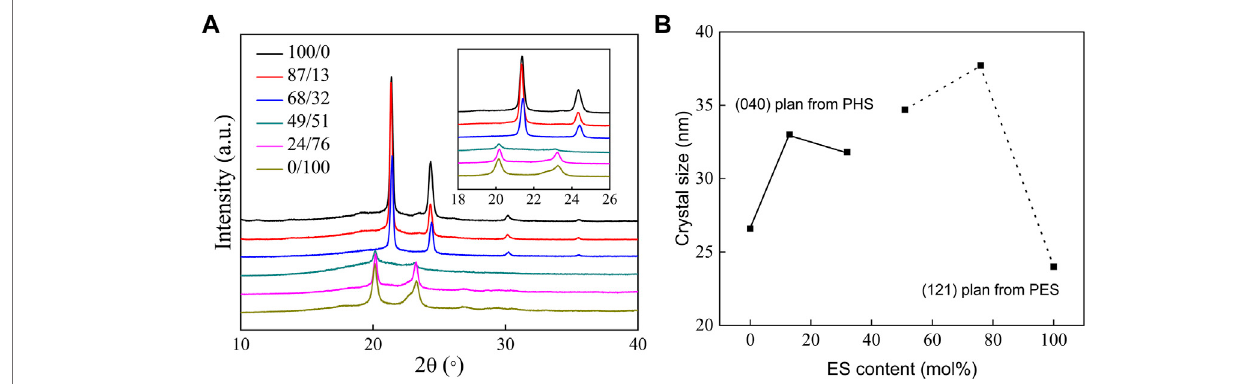
FIGURE 3 | XRD patterns of PHS, PES, and P(HS-co-ES) copolyesters (A) and the corresponding crystallite sizes calculated using the Debye – Scherrer equation (B)